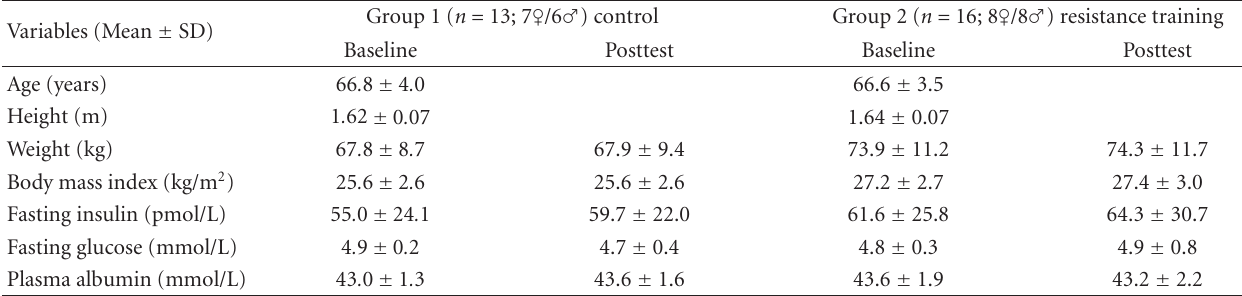
Table 1: Physical and biochemical characteristics of subjects by groups before and after intervention.